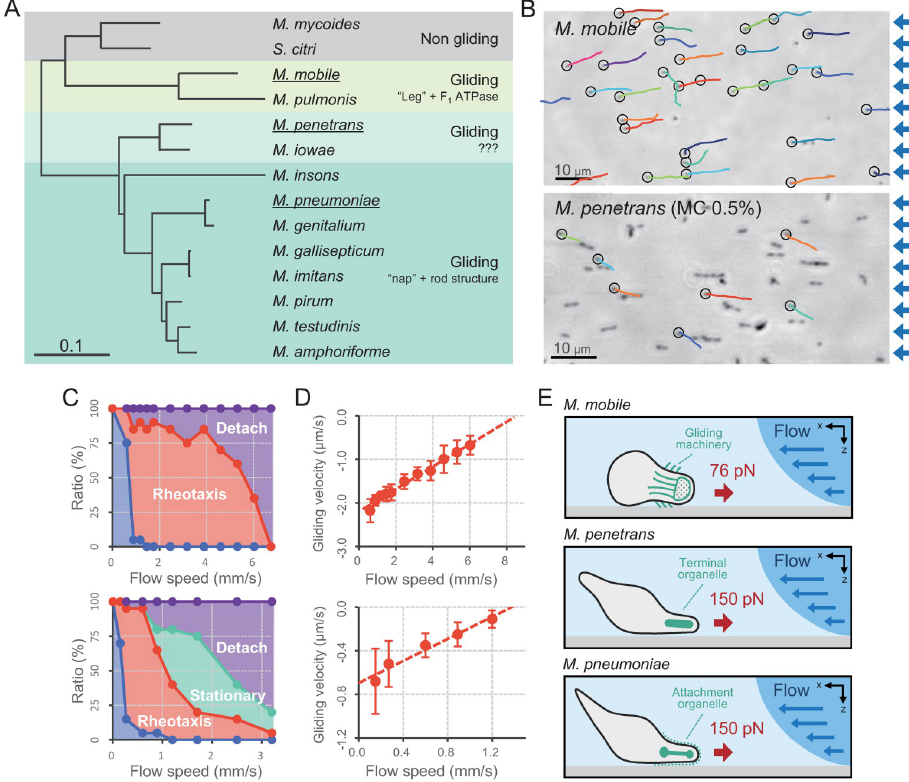
Fig 5. Rheotactic behaviors in gliding Mycoplasma . (A) Phylogenetic tree based on the sequences of the 16S ribosomal RNA. Twelve gliding species and two non-gliding species in Mollicutes are presented. Gliding mycoplasmas were categorized into three types based on external and internal structural features responsible for adherence and gliding motility [62]. The scale represents the number of substitutions per site. The species used in this study are underlined. (B) Cell trajectories. The trajectories (color lines) of M . mobile for 6 s and M . penetrans for 15 s were overlayed to each cell image under phase-contrast microscopy. Fluid flow was applied from the right side of the image at 1.7 mm/s for M . mobile and 0.6 mm/s for M . penetrans . The cells of M . penetrans were observed in the presence of 0.5% methylcellulose. The start position of a trajectory is marked by the black circle. The blue arrows on the right side of the image represent the direction of the fluid flow. (C) Fraction of cell motility pattern. The motility pattern under fluid flow was categorized into five groups, as presented in Fig 2B. Upper : M . mobile . Lower : M . penetrans . (D) Relationship between the cell gliding velocity and flow speed. The average and SD of the gliding velocity during positive rheotaxis are plotted for each flow speed ( N = 15). The dashed lines present linear approximations. Upper : M . mobile . Lower : M . penetrans . (E) Schematic of rheotaxis in three gliding mycoplasmas. The estimated maximum forces, the polar cell shapes, and the structures responsible for adherence and gliding motility are presented. Top : M . mobile . Middle : M . penetrans . Bottom : M . pneumoniae